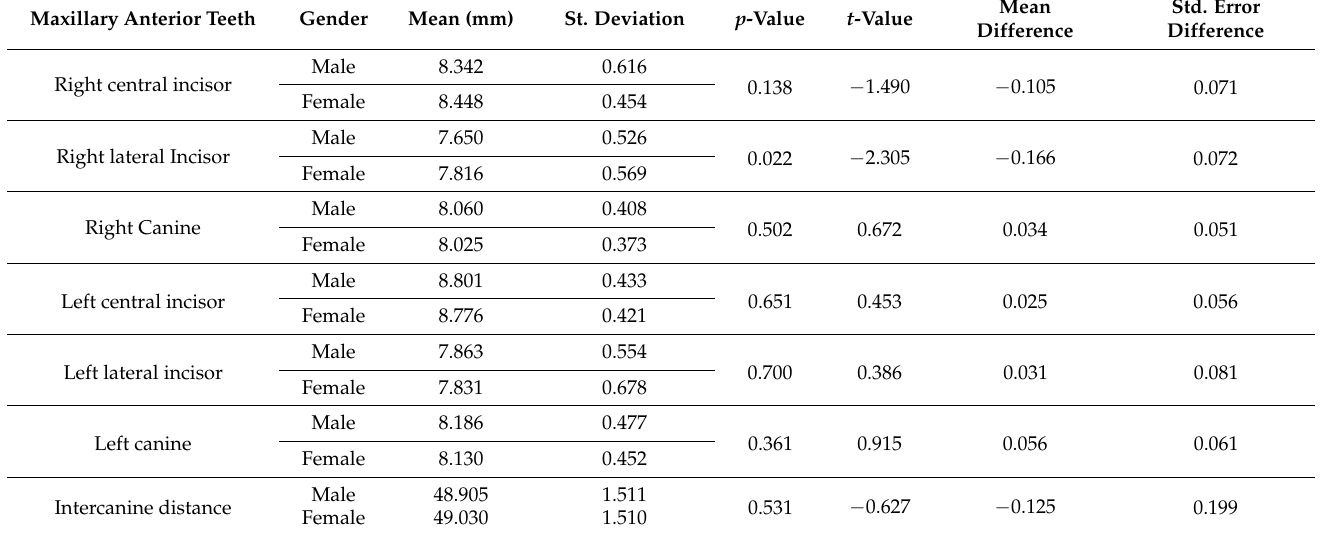
Table 4. The comparison between mesiodistal width of maxillary anterior teeth obtained through 3D models, in both sexes (independent t -test analysis (Male n = 112 Female n = 118).